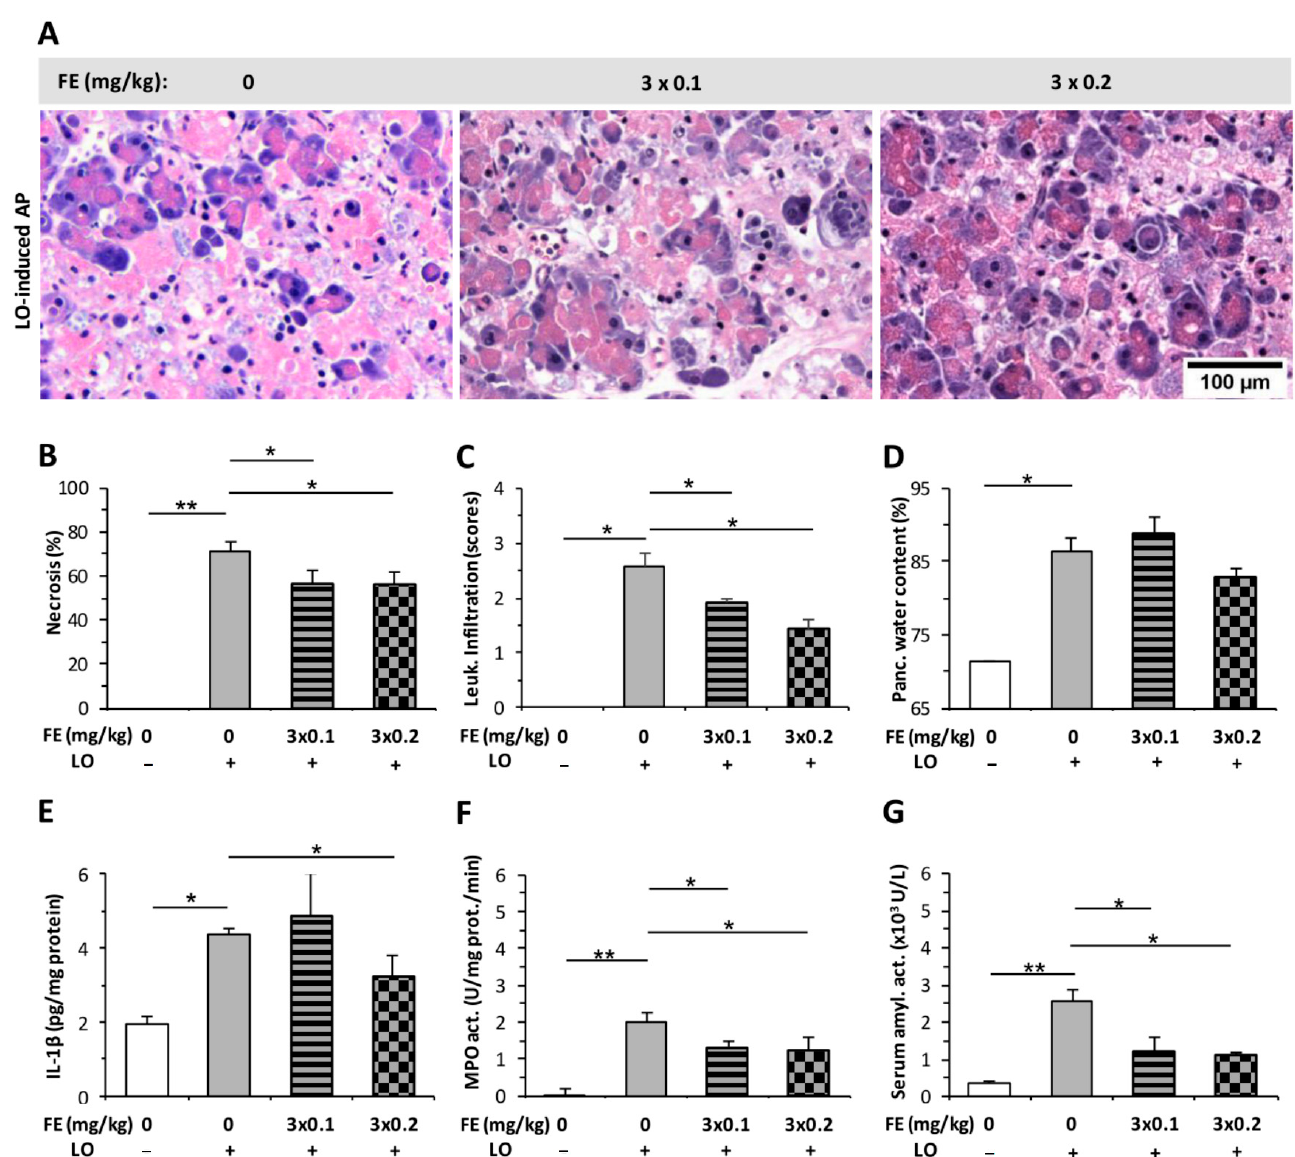
Figure 3. Fentanyl (FE) treatment started after the induction of L-ornithine (LO) acute pancreatitis (AP) reduces disease severity. ( A ) Representative histopathological images of pancreatic tissues of the treatment groups. Bar charts show the extent of pancreatic ( B ) necrosis, ( C ) leukocyte infiltration, ( D ) water content, ( E ) interleukin-1 β (IL-1 β ) concentration, ( F ) myeloperoxidase (MPO) activity, and ( G ) serum amylase activity measurements. Values represent mean with standard error, n = 10–18.